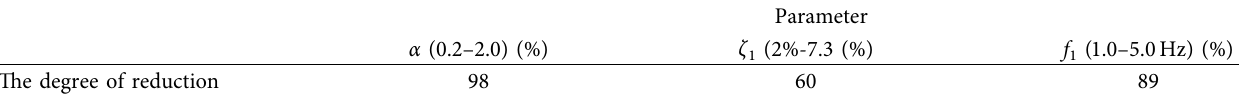
Table 11: The max reduced amplitude of structural dynamic responses with α , ζ